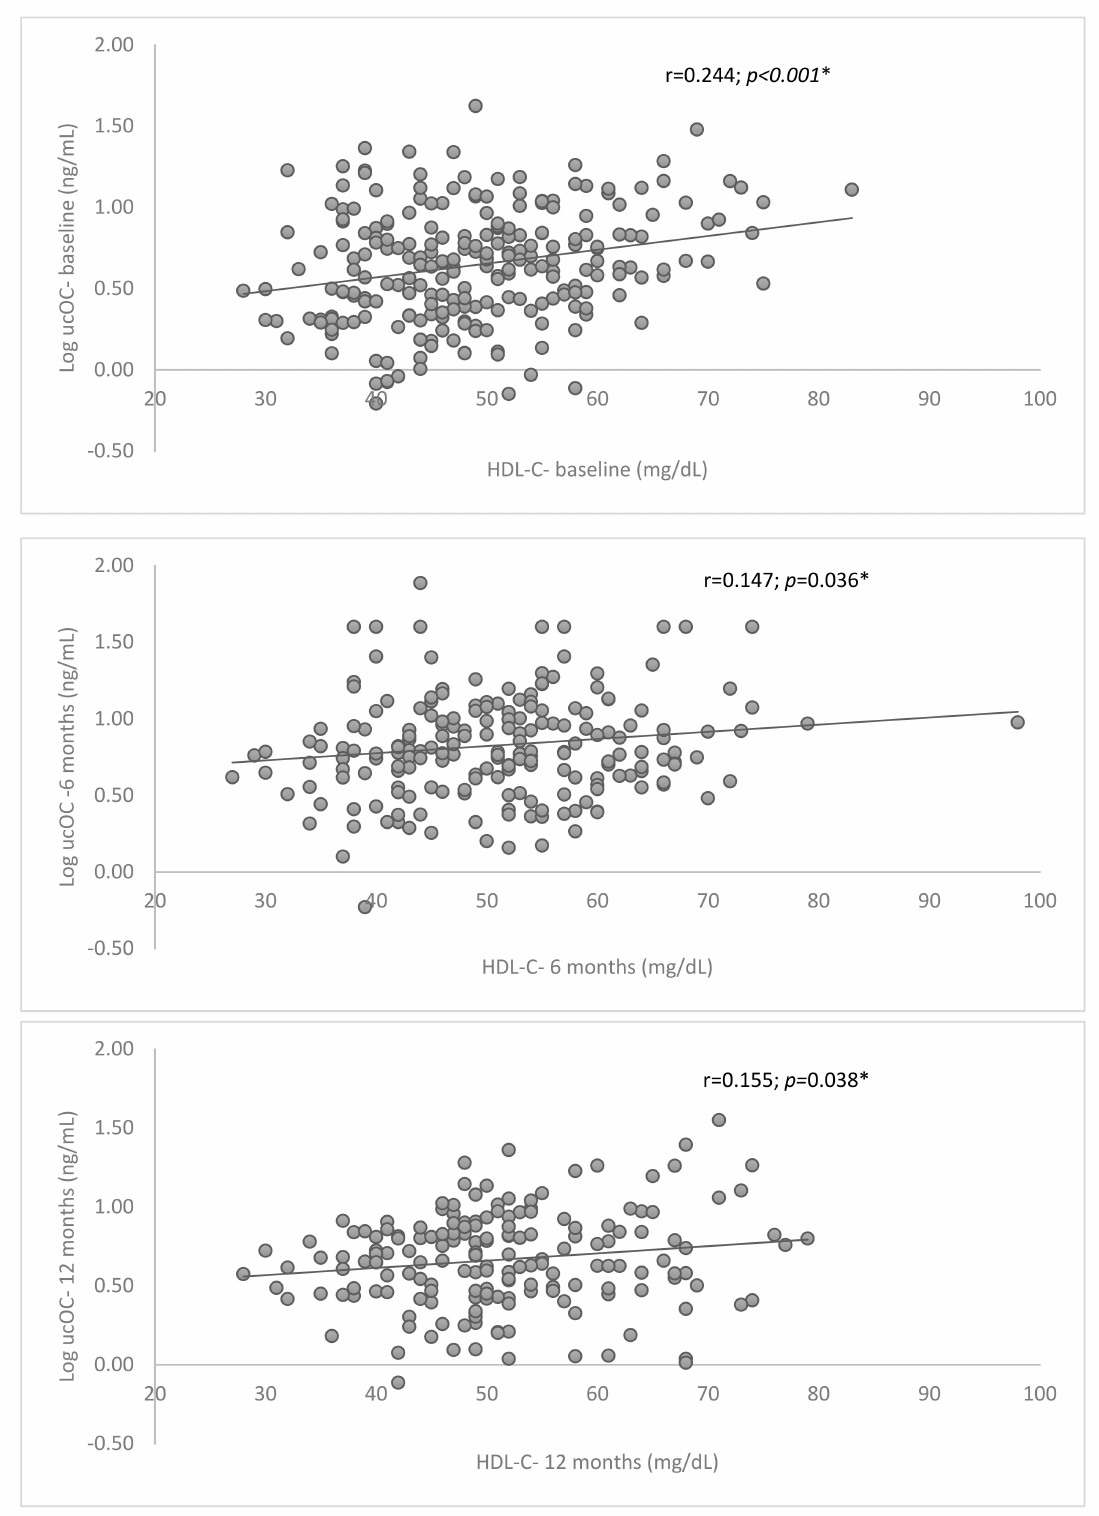
Figure 1. Relationship between serum ucOC levels and HCL − C at baseline, at 6 and 12 month follow-up. * Spearman correlation test <